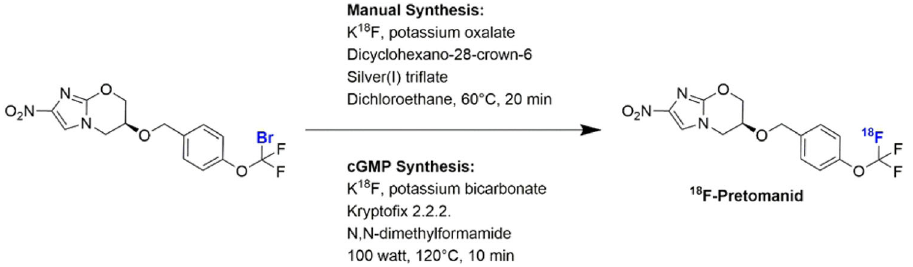
Fig. 2 | Synthesis of 18 F-pretomanid. 18 F-pretomanid was obtained through 18 F- fl uorinationofanaryl-bromodi fl uoromethoxylprecursor.Manualsynthesiswas